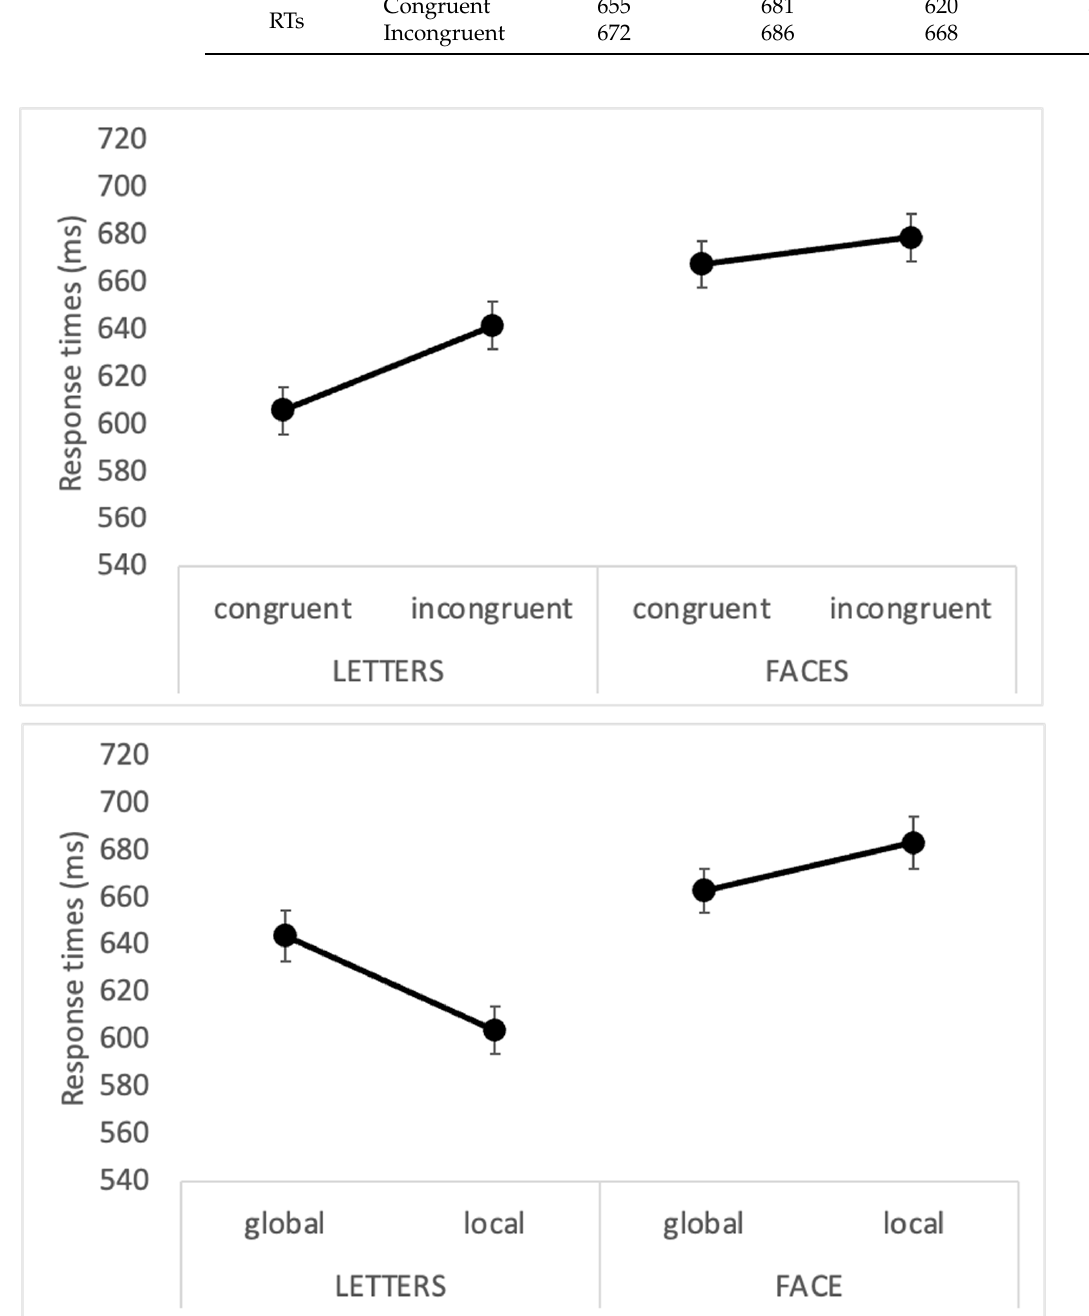
Figure 4. Experiment 2. The results of the two interactions are reported: stimulus x congruency in the upper panel and stimulus x task in the lower panel. The first interaction revealed that, at 500 ms, both faces and letters undergo a congru- ency effect, with longer response times in case of incongruency between the global and the local